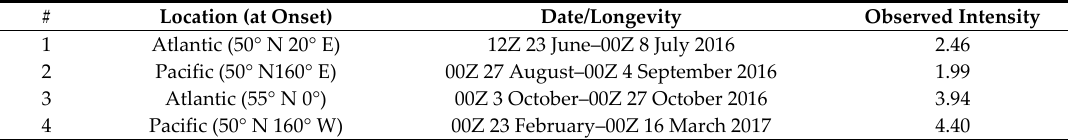
Table 2. Description of blocking events discussed. Name, date of event/longevity and blocking intensities from observed data. Intensities calculated are mean values over the duration of the blocking event